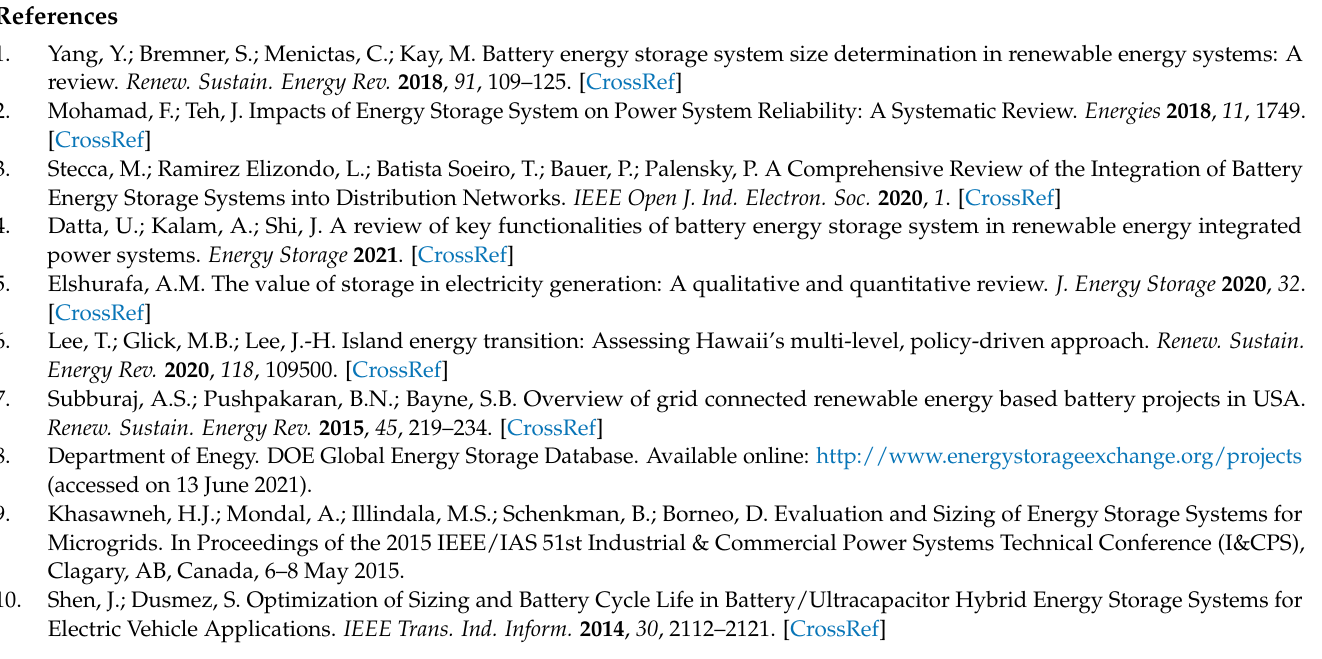
Figure A1. IC signatures for the charges during the energy test. Different colors correspond to the BESS 384